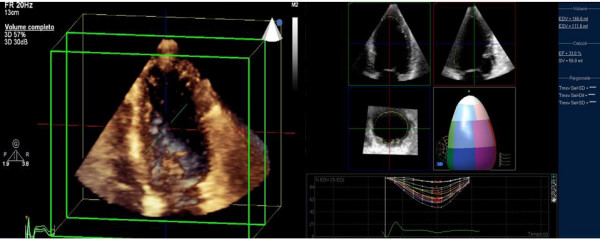
Volumetric data obtained only from the apical RT-3D window and displayed as conventional 2D apical which where digitalized with final interpretation made off-line with the steering and tilting of the image planes for proper alignment and visualization of various scan.